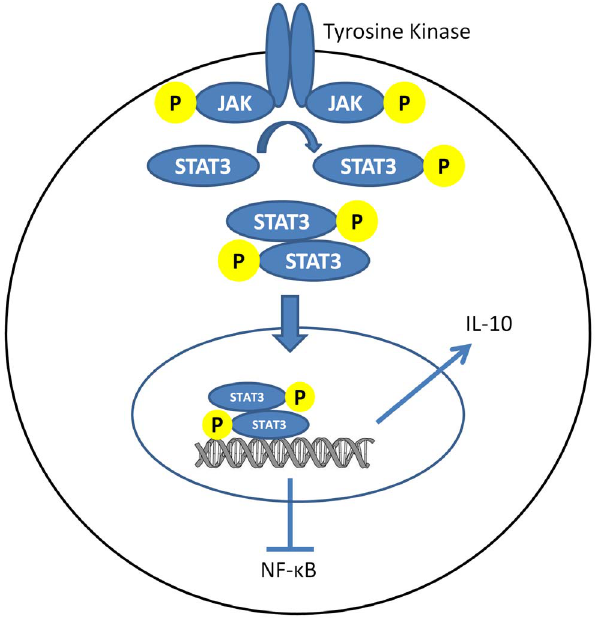
Figure 11. Diagram of simplified Interleukin-10 (IL-10) path- way. A hyperosmotic condition induces cellular shrinkage and activates tyrosine phosphorylation of Janus kinases (JAK) to subsequently phosphorylate STAT3 and IL-10 production.